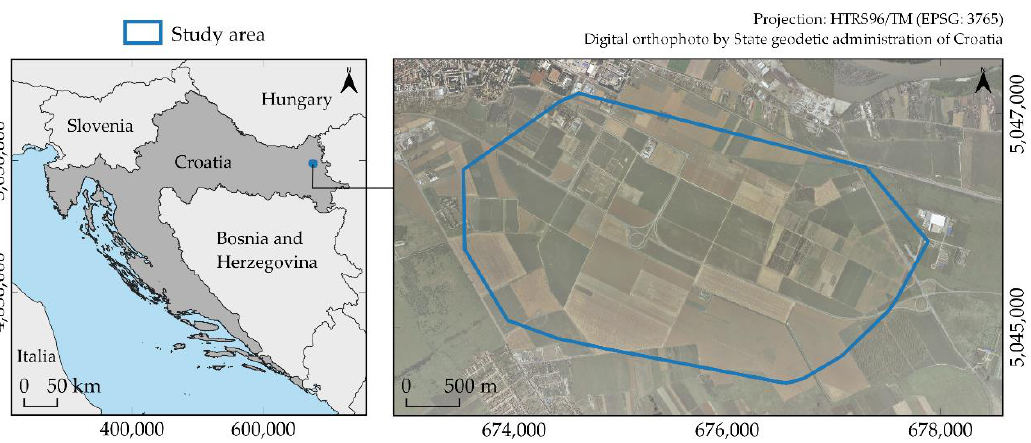
Figure 2. Study area and its location within the Republic of Croatia.